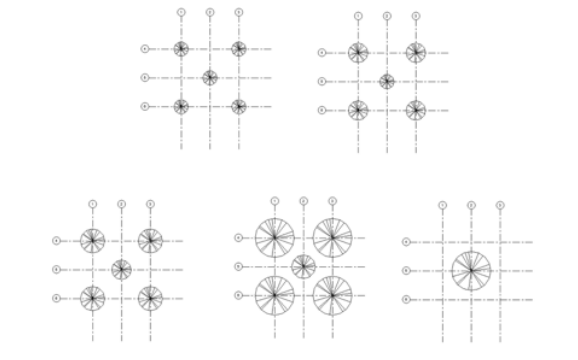
Figur 7. Setting the different phases according to the time parameter on a Populus Alba and Quercus mixed plant system. From left to right: moment of planting, five years after planting, ten years later, fifty years and finally 100. Through this tool it is possible to immediately see the changes due to the passage of time not only to the scale of detail as in example but also on